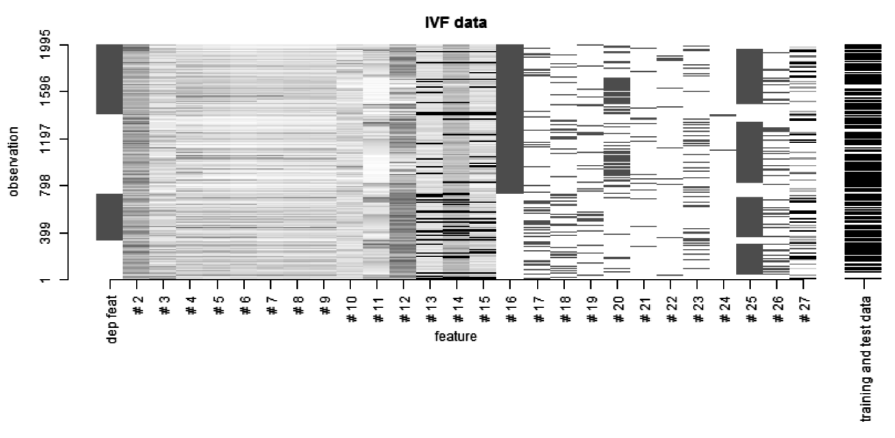
Figure 1. The dataset